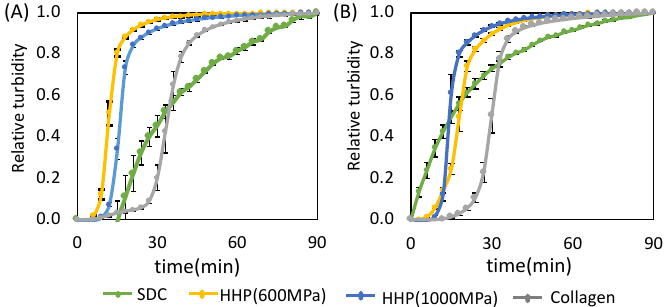
Figure 4. The gelation kinetics of decellularized extracellular matrix (d-ECM) hydrogels and collagen hydrogels. Representative curves are for d-ECM hydrogels derived from ( A ) the urinary bladder matrix (UBM) and ( B ) small intestine submucosa (SIS) at 0.8% concentration. SDC and HHP represent the method of decellularization of each tissue.